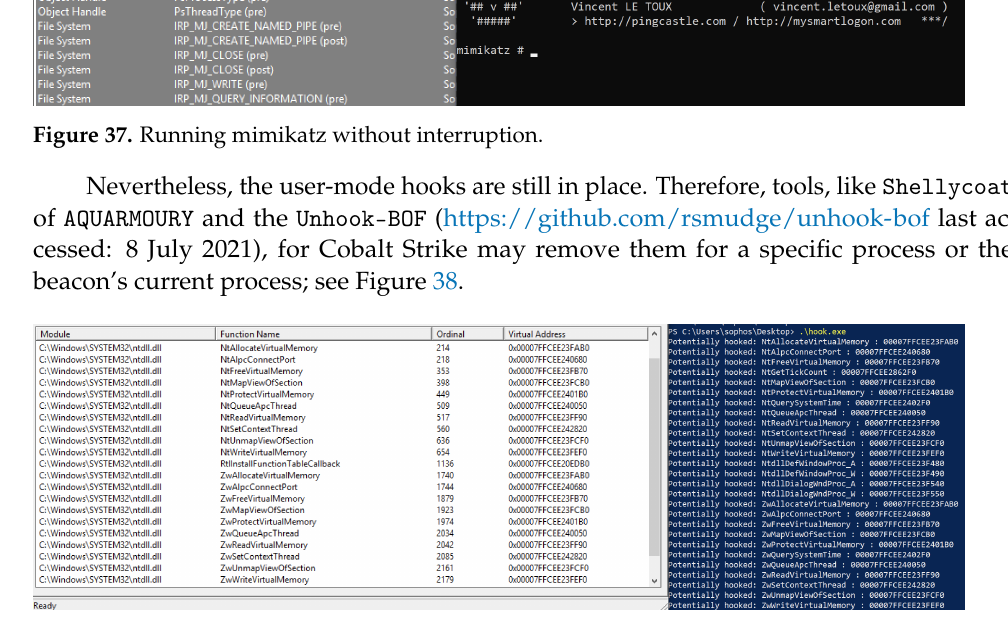
Figure 38. Sophos’s usermode API